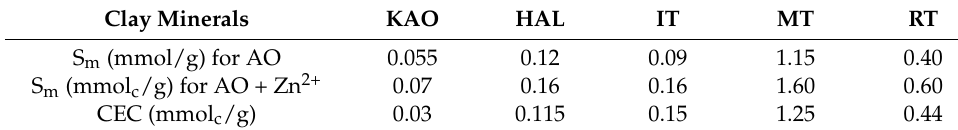
Table 1. AO or AO + Zn 2+ sorption capacity on different types of clay minerals. Clay Minerals